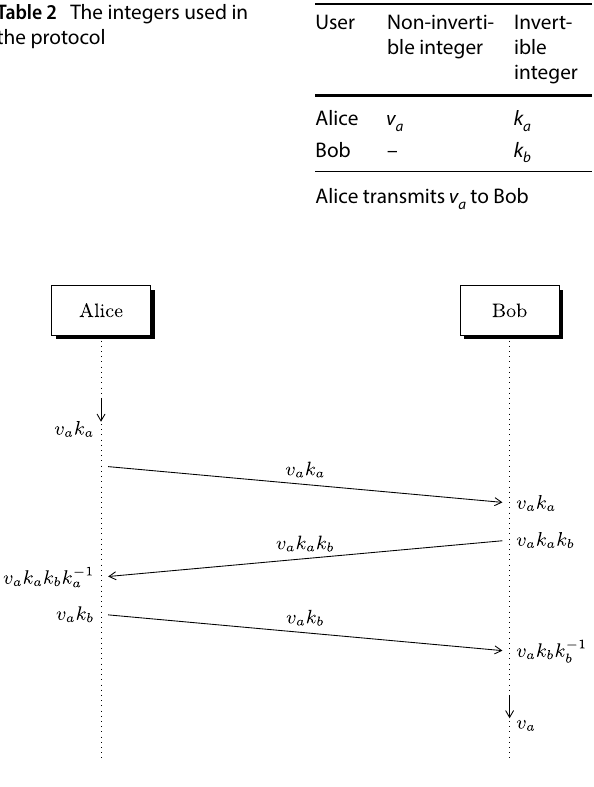
Fig. 1 Multiplication-based protocol. All computations in the protocol are performed mod pq . The prime numbers p and q are known publicly